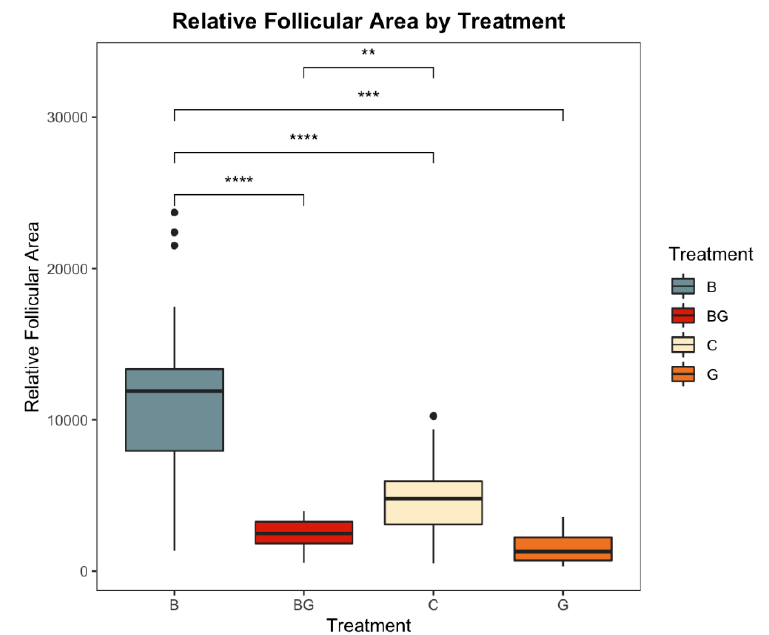
Figure 10. Boxplot of relative follicular area by treatment. The aerial photograph was analyzed by Image J and used to determine the relative follicular area by each treatment. Datasets were analyzed by the Tukey-Kramer test, with significance level: 0.01 (**), 0.001 (***), <0.001 (****)”.